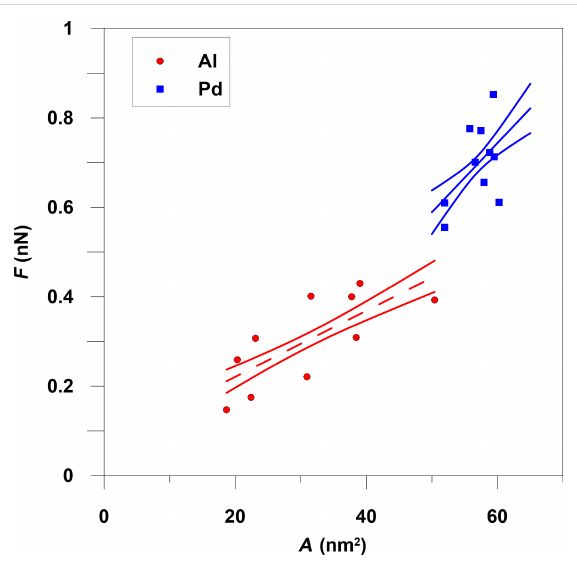
Figure 4: Friction force as a function of the contact area with confi- dence intervals of the approximation at a temperature of 300 K. The linear approximations for the slopes of the average friction force for aluminum and palladium are 0.007 nN/nm 2 and 0.015 nN/nm 2 , respec- tively.